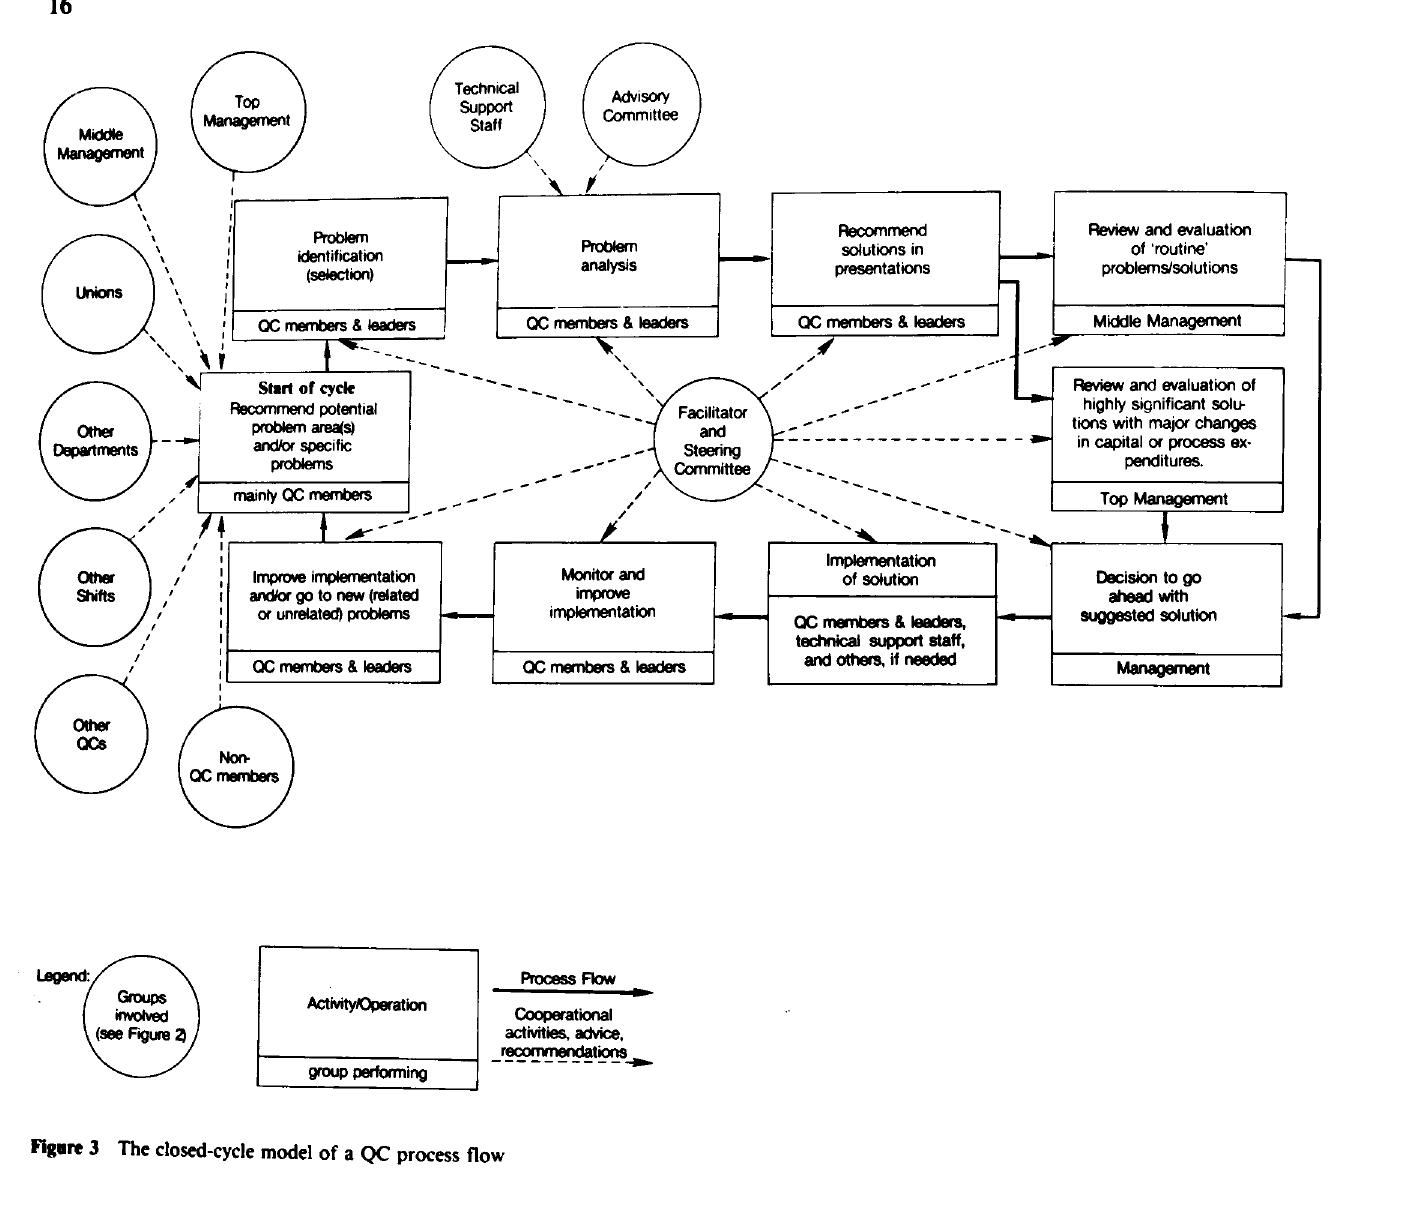
Activityl()peration group performing